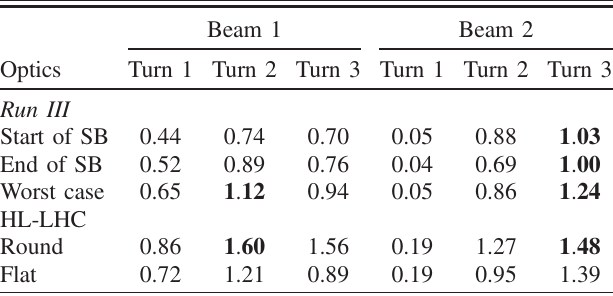
Run III and HL-LHC shown as the radial orbit excursion in units of beam σ . Run II optics were used and adapted to Run III parameters. For HL-LHC the HLLHCv1.4 optics were used. The weighted average of the orbit excursion for the three different beam parts, as defined above, is shown, over three